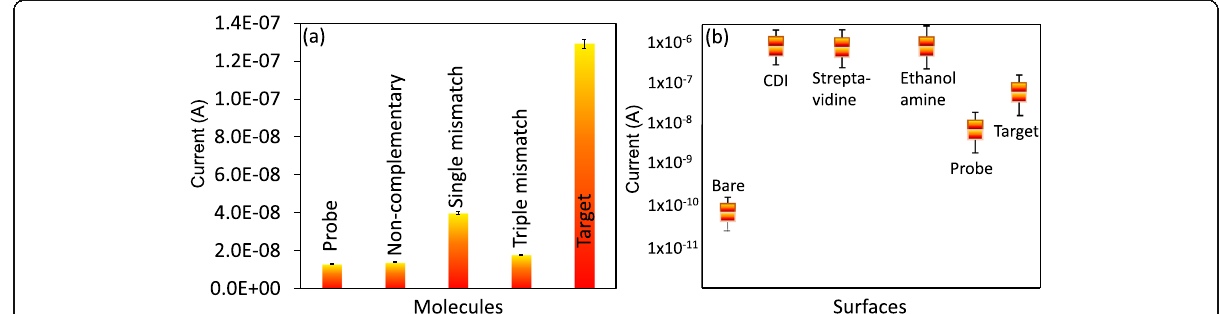
Fig. 6 High-performance analysis. a Specificity analysis. Target sequences were discriminated from the noncomplementary and single- and triple- mismatched sequences. b Reproducibility test. Averaged values are displayed with triplicate